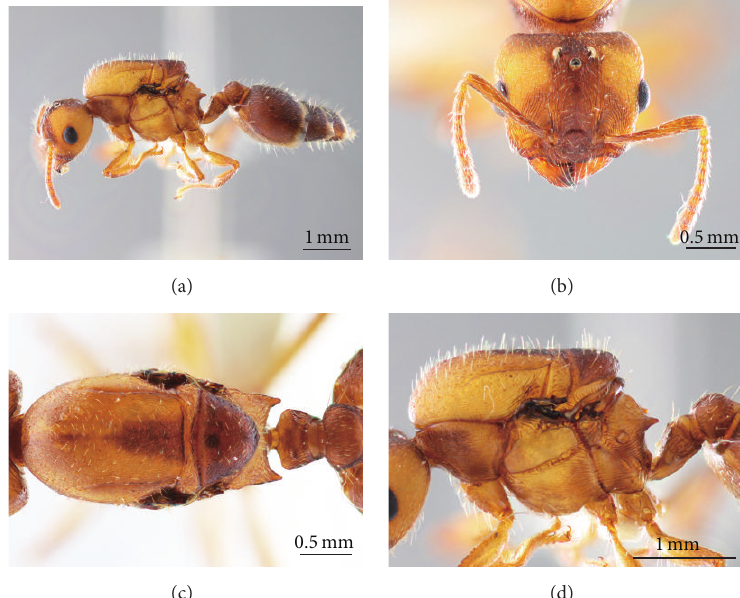
Figure 3: Crematogaster coriaria Mayr, 1872, queen: (a) body in lateral view; (b) full-face view of head; (c) dorsal view of mesosoma; (d) lateral view of mesosoma, petiole, and postpetiole.